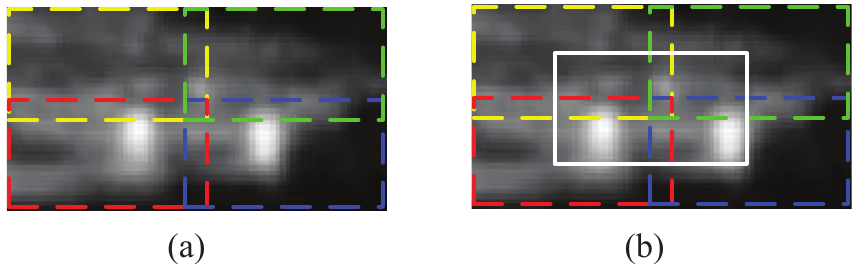
Figure 4. Two blocking methods to divide an infrared chip into multiple segments. ( a ) The chip is divided into four overlapped quadrants; ( b ) The chip is divided into five overlapped